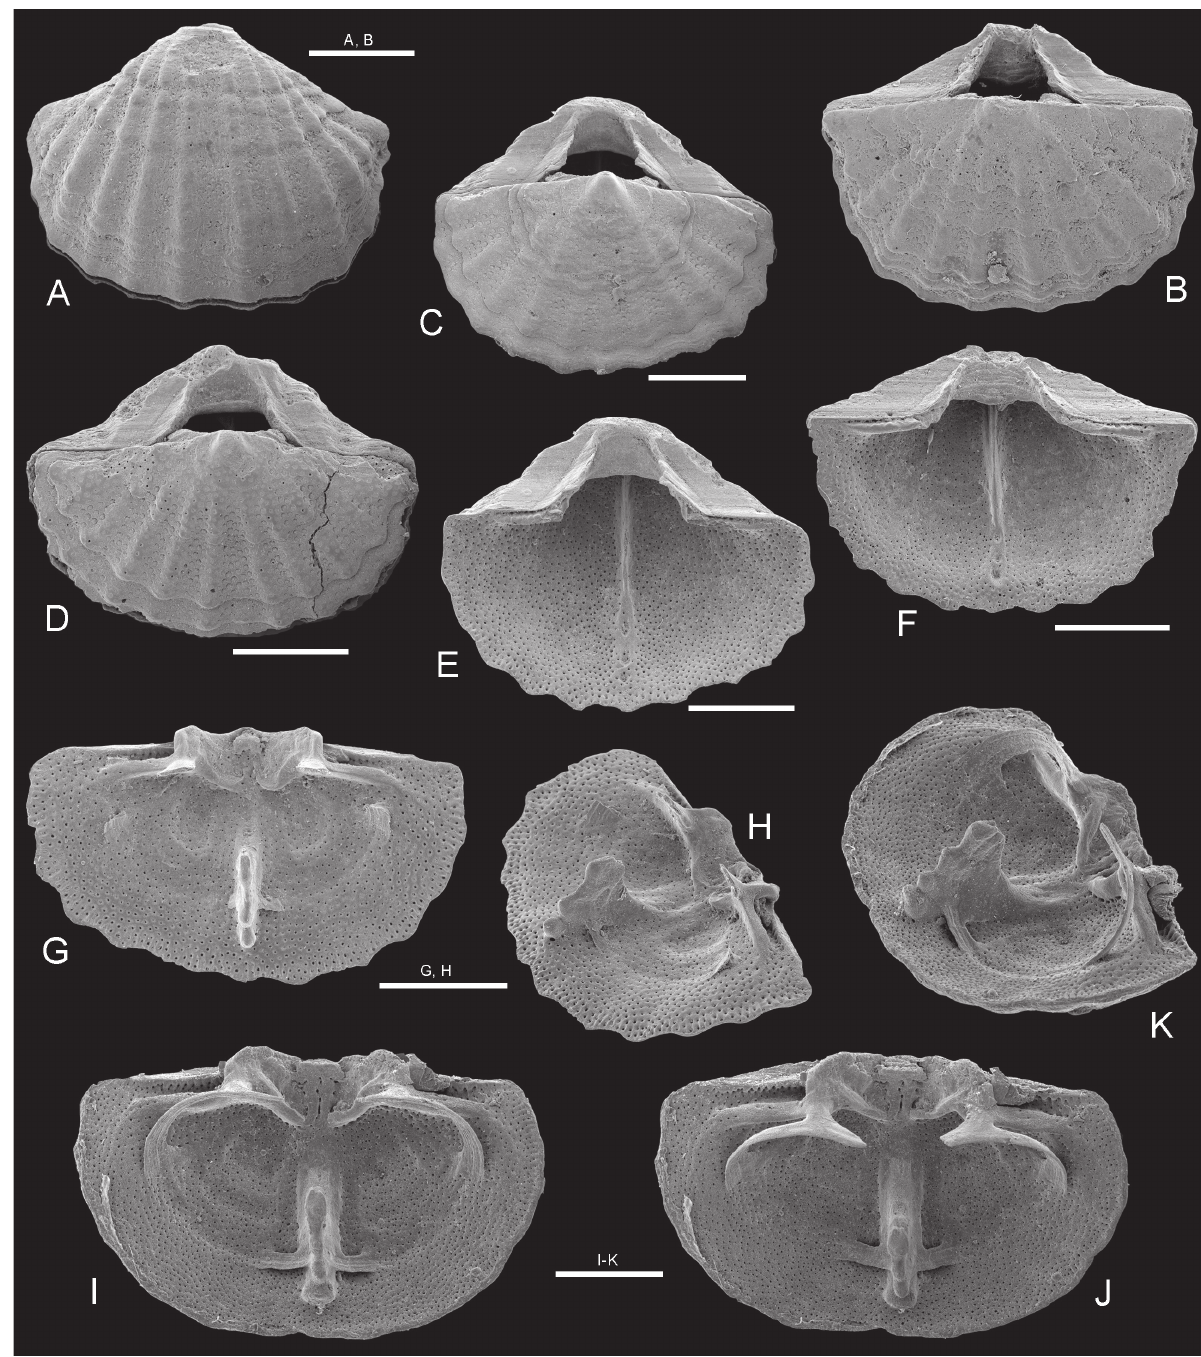
Fig . 3. – Argyrotheca jacksoni cooper, 1973, Persian gulf; a, B, ventral and dorsal views of complete specimen, Jana island, sample Pg95- 41, 5-10 m, sMF 869 03; c, d, dorsal views of complete specimens, sMF 869 04-05, c, karan island, sample Pg95-39, 10-12 m, d, Jana island, sample Pg95-41, 5-10 m; e, F, inner views of ventral valves, karan island, sMF 869 06-07, e, sample Pg95-39, 10-12 m, F, sample Pg95-44, 11 m; g-k, inner views of dorsal valves, sMF 869 08-09, g, h, inner and oblique views to show high median septum, karan island, sample Pg95-39, 10-12 m; i-k, inner, tilted and oblique views to show short crura, massive cardinal processes and high median septum, Jana island, sample Pg95-41, 5-10 m, sMF 869. all seM. scale bars: 1